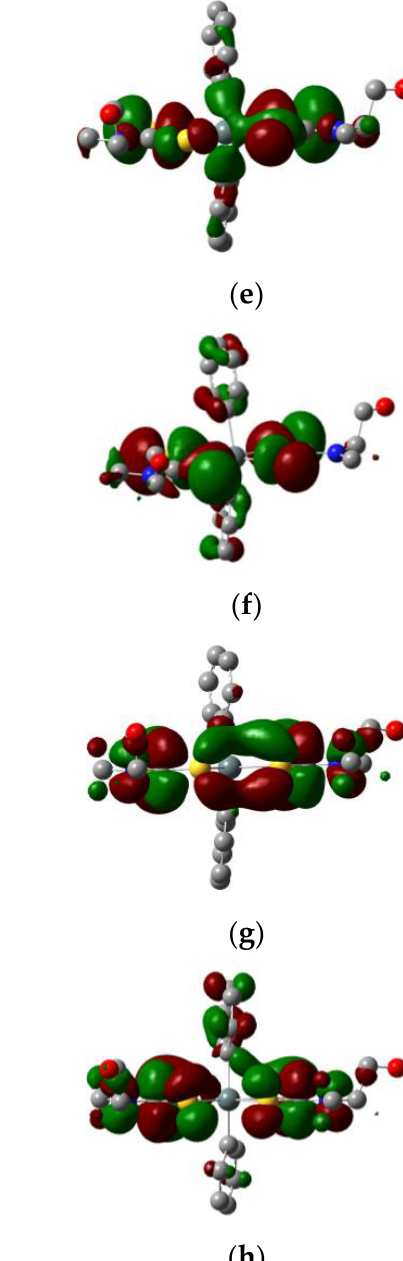
Figure 2. FMO isosurfaces of the complexes of [(C 6 H 5 )(Cl)Sn(L) 2 ] ( a ) HOMO − 1, ( b ) HOMO, ( c ) LUMO, ( d ) LUMO+1, and [(C6H5)2Sn(L)2] ( e ) HOMO − 1, ( f ) HOMO, ( g ) LUMO, and ( h ) LUMO+1 (Iso-value = 0.020000).